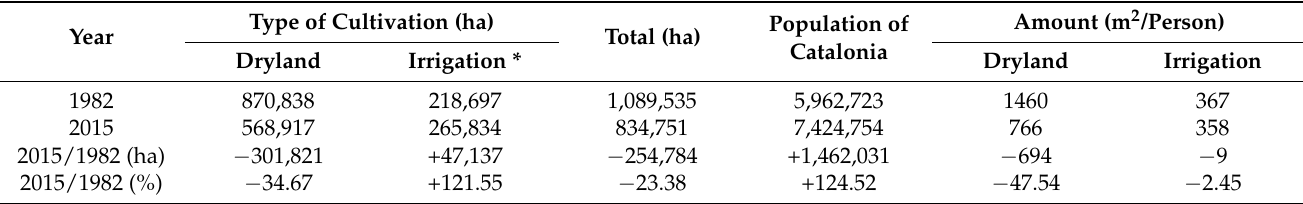
Table 2. Distribution of the type of cultivation and availability of arable land per inhabitant in Catalonia. Source: Idescat. Type of Cultivation (ha) Amount (m 2 /Person) Population of Total (ha) Year Catalonia Dryland Irrigation * Dryland Irrigation 1982 870,838 218,697 1,089,535 5,962,723 − 9 +121.55 − 23.38 +124.52 − 47.54 − 2.45